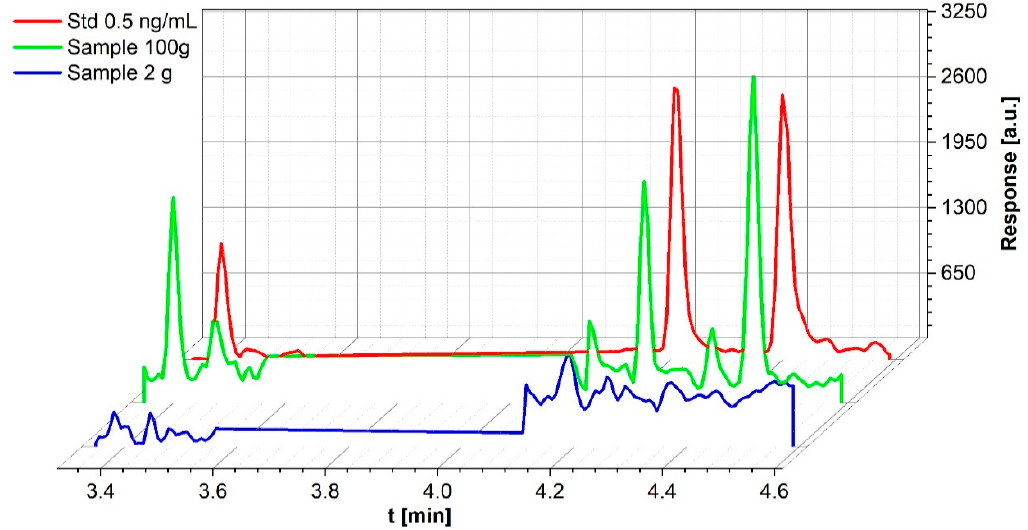
Figure 4. Comparison of the same sediment sample once processed with 2 g freeze-dried material and once with 100 g wet sediment with a 0.5 ng/mL standard. While no explosives were found in the lyophilized sample, 0.6 ng TNT (1), 0.3 ng 4-ADNT (2), and 0.5 ng 2-ADNT (3) were detected in the wet one.